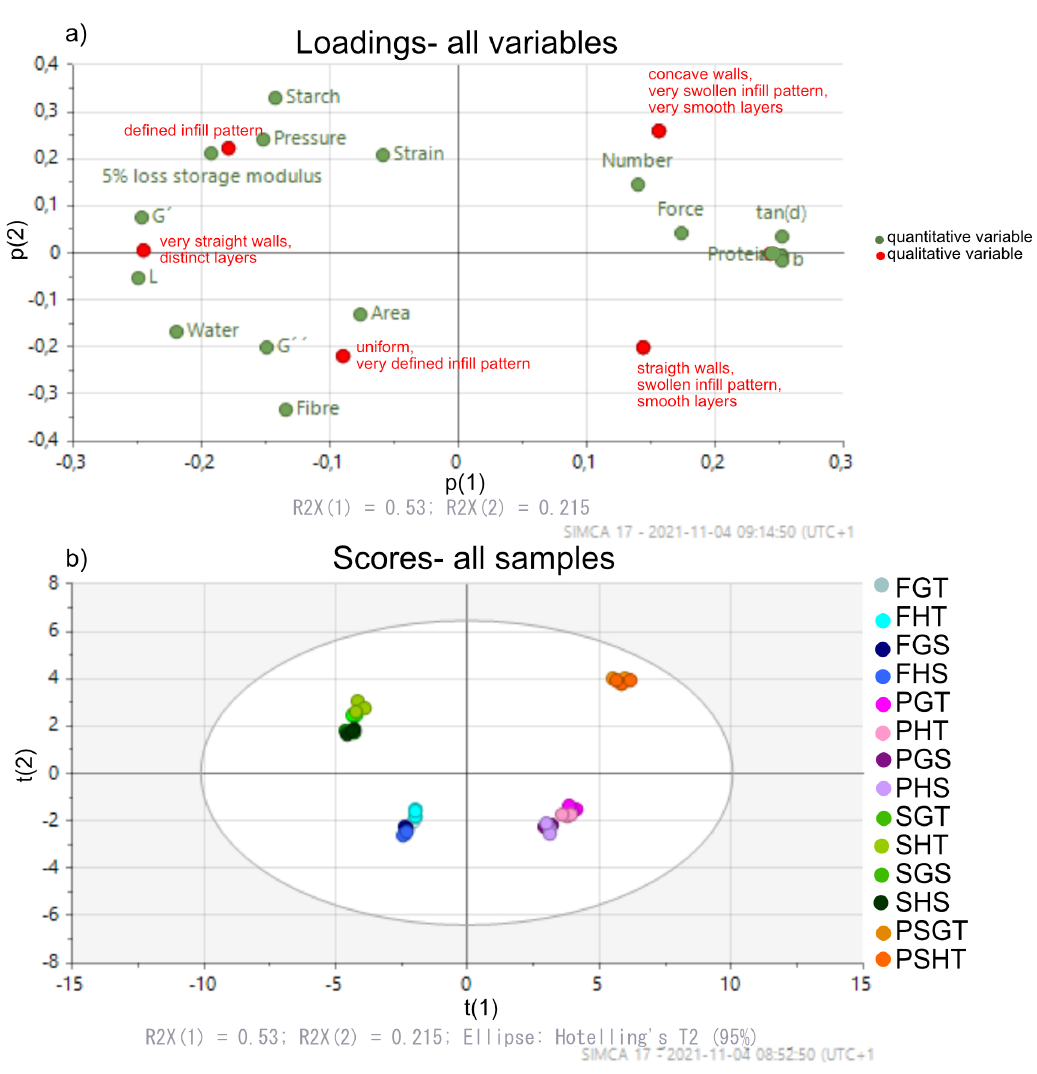
Figure 6. Principal component (PC) analysis ( a ) component plot and ( b ) samples in PC plot. F Fibre-rich, P Protein-rich, S Starch-rich, PS protein- and starch-rich, G Grid, H honeycomb, T Top, S